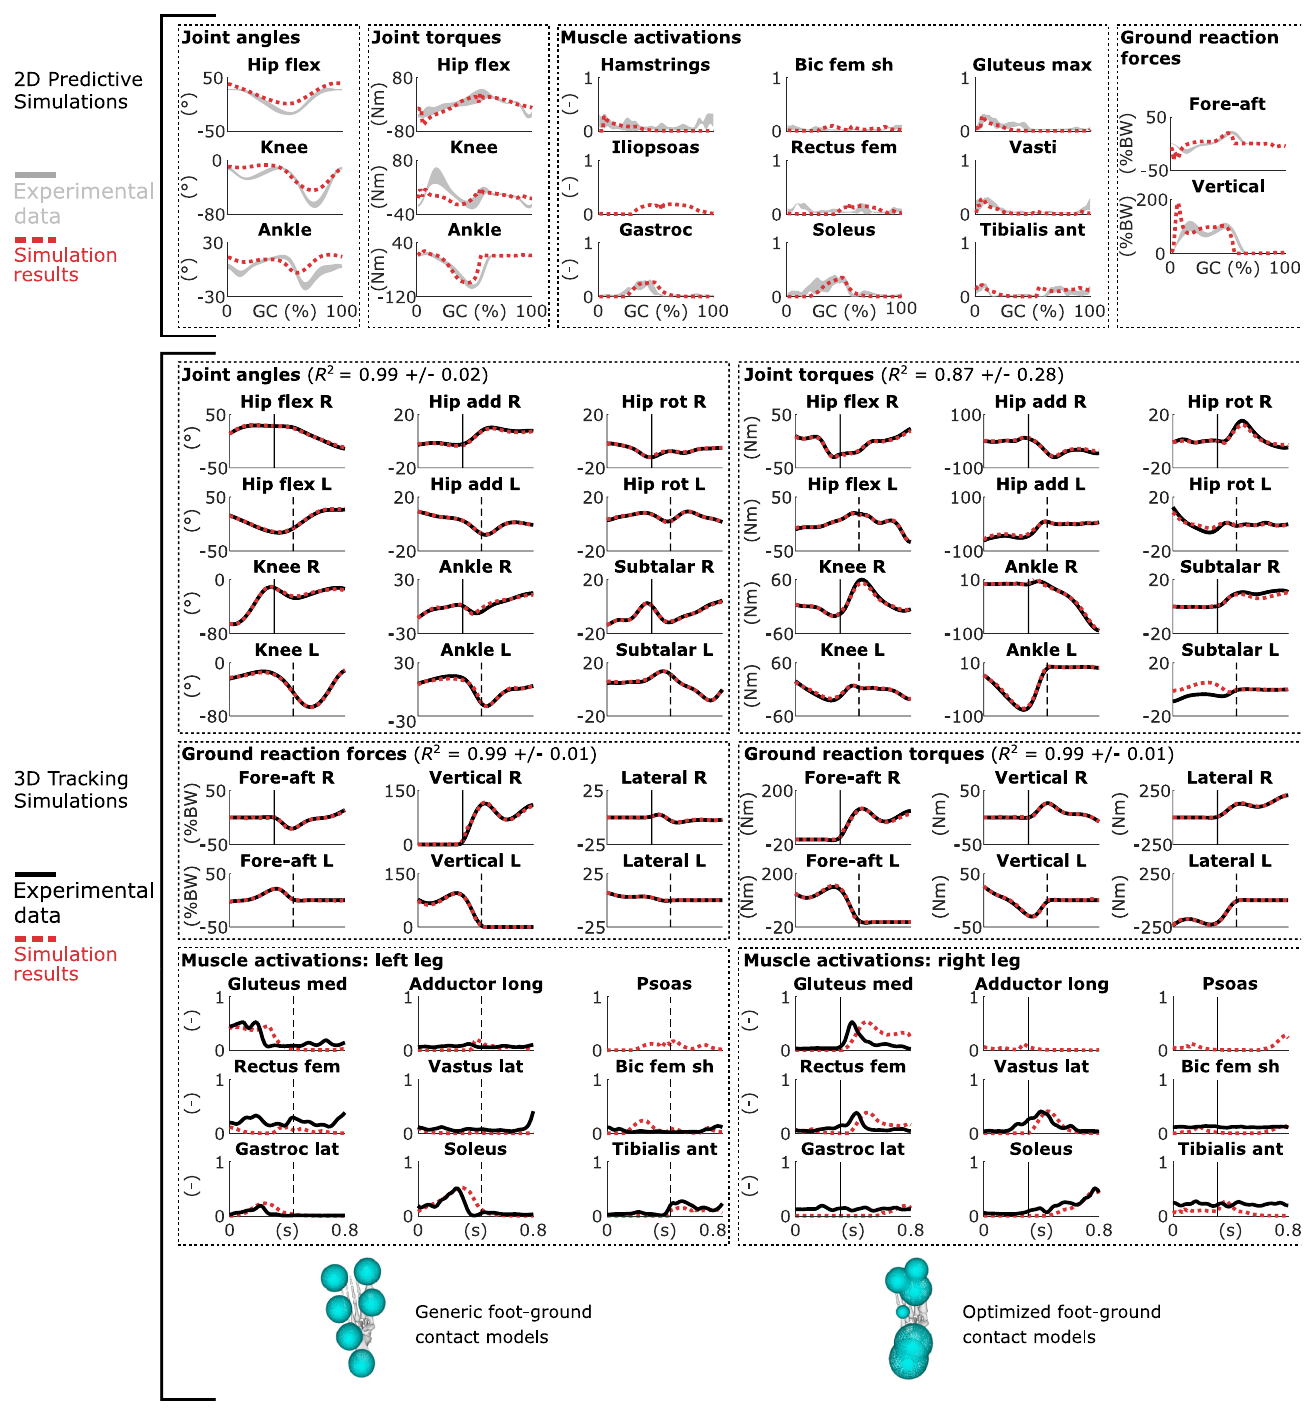
Fig 5. Results from trajectory optimization of walking. (Top) Results from 2D predictive simulations of walking (joint angles: flex is flexion, GC is gait cycle; muscle activations: bic is biceps, fem is femoris, sh is short head, max is maximus, gastroc is gastrocnemius, ant is anterior; ground reaction forces: BW is body weight). Experimental data are shown as mean ± two standard deviations. (Bottom) Results from 3D tracking simulations of walking (joint angles: R is right, L is left, add is adduction, rot is rotation; muscle activations: med is medialis, long is longus, lat is lateralis). The vertical lines indicate right heel strike (solid) and left toe-off (dashed); only part of the gait cycle, when experimental ground reaction forces are available, is tracked. The experimental electromyography data is normalized to peak muscle activations. The foot diagrams depict a down-up view of the configuration of the contact spheres of the right foot pre-calibration (left: generic) and post- calibration (right: optimized). The coefficient of determination R 2 is given for the tracked